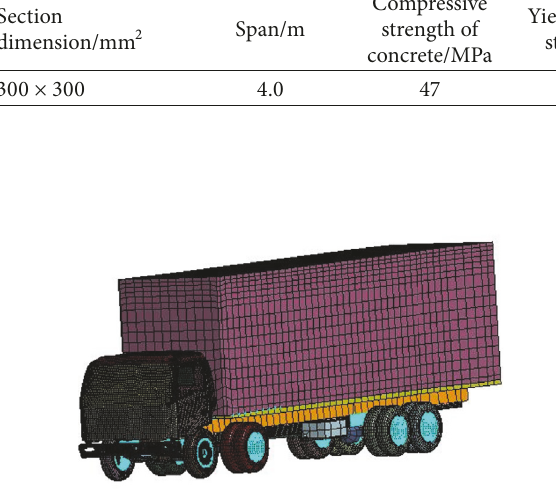
Figure 5: Numerical model of truck.